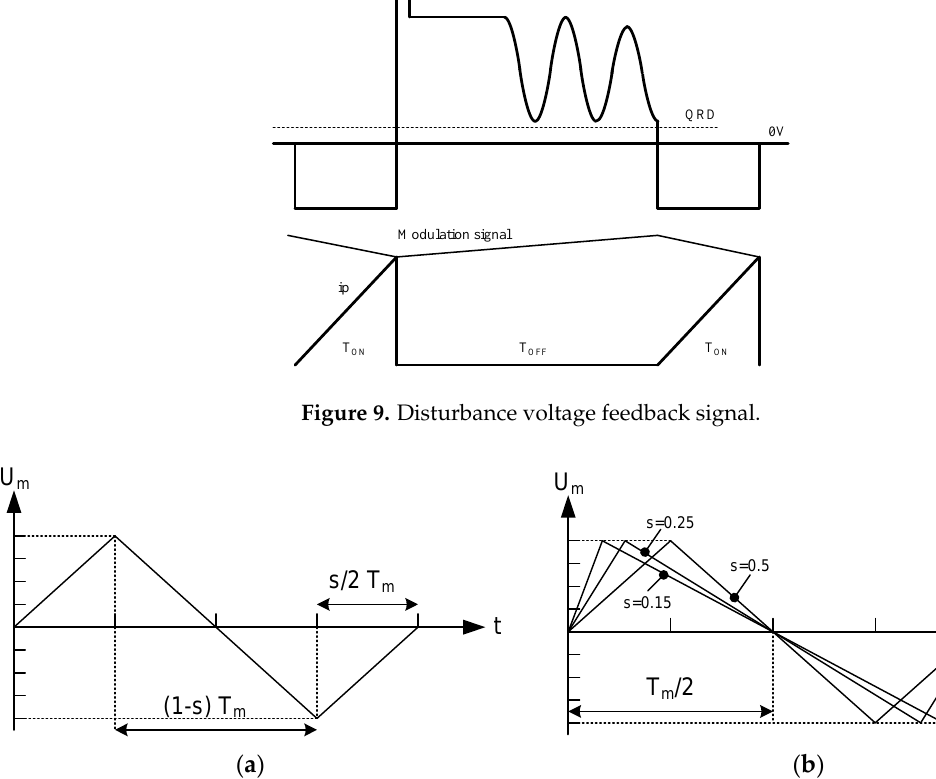
Figure 10. Triangular modulation signals: ( a ) signals; ( b ) different s ratio values.